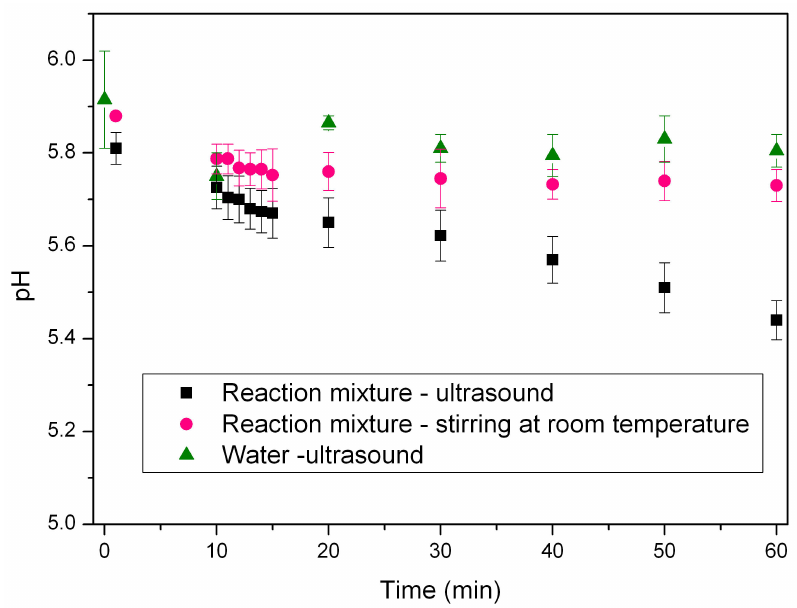
Figure 5. pH of the metalation reaction (TMePyP and 1 equivalent of Cu(OAc) 2 · H 2 O in 1 mL of water) vs. time under ultrasound (5 independent experiments, black) and under stirring at room temperature (2 independent experiments, pink), pH of water under ultrasound (2 independent experiments